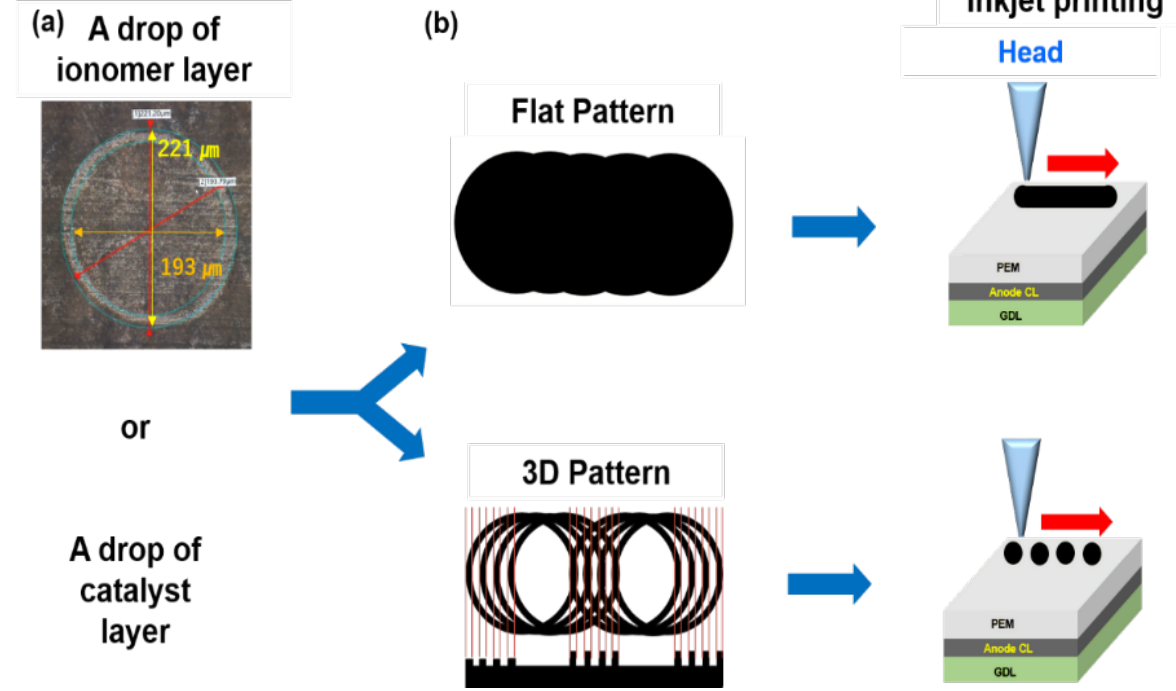
Figure 3. ( a ) Photographs of the ( a ) printed ionomer or catalyst layers on the Nafion film. ( b ) Schematic of the design and fabrication of CCL structures with flat and 3D patterns.